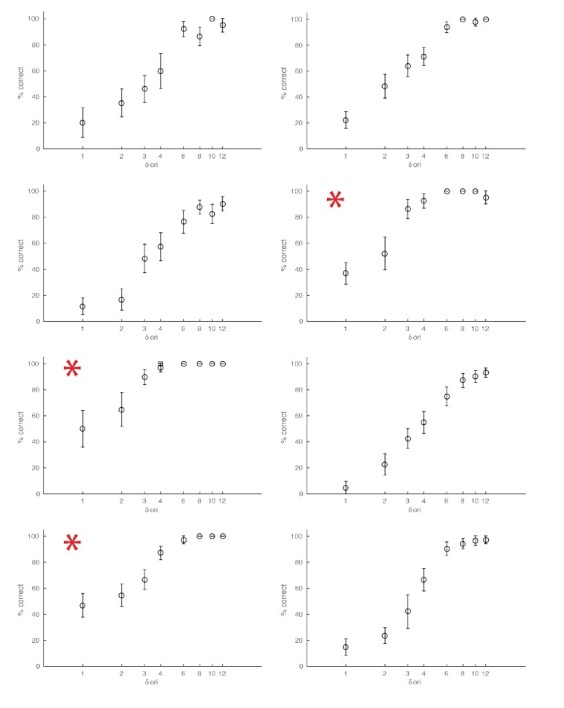
Examples of behavioral sessions without optogenetic stimulation.The red asterisks mark behavioral sessions where the baseline orientation (orientation of the non-target stimuli) was either horizontal or vertical.